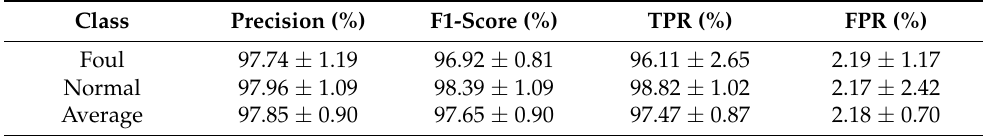
Table 4. Performance metrics of CNN two-class configuration.